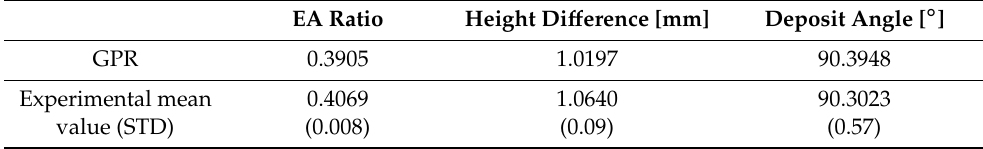
Table 3. Experimental values and predictions from the GPR model with the optimal